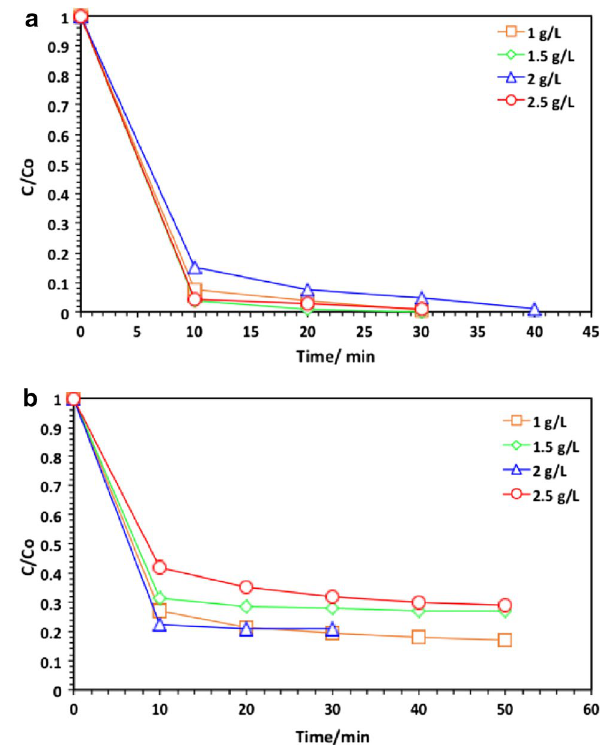
Fig. 6 Effect of different AS400 doses on a LFR (Dye H 2 O 2 800 mg/L; pH 3.0) and b LA (Dye o 50 mg/L; H 2 O 2 200 mg/L; pH 3.0) azo-dyes removal during oxidation for different time ( t